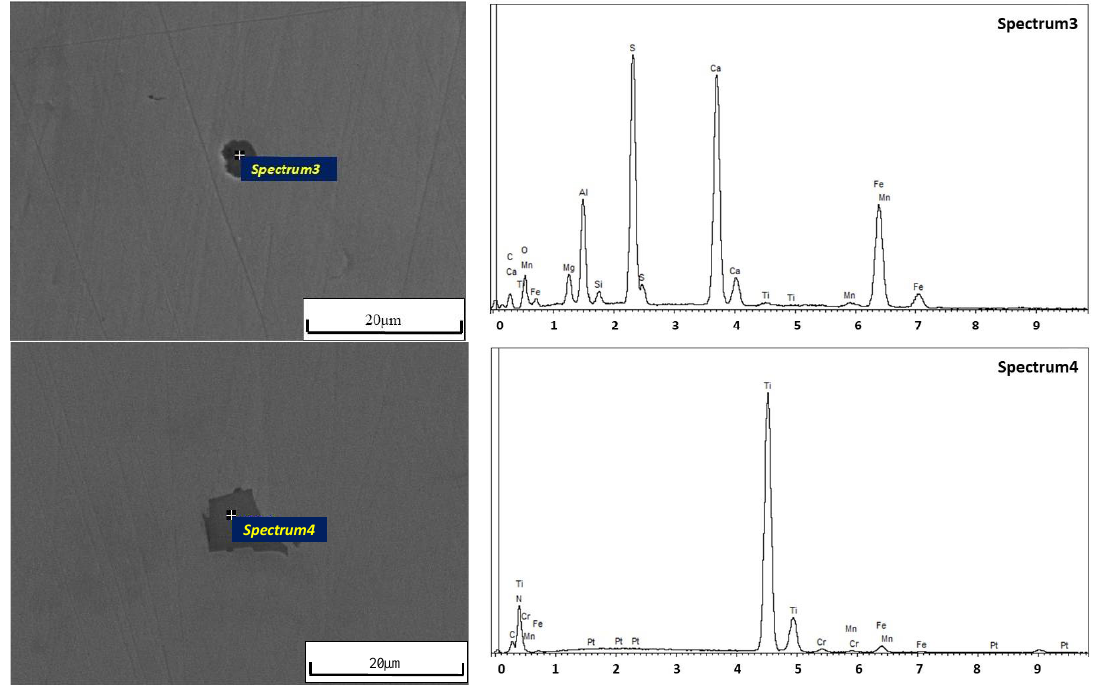
Figure 12. Morphology and distribution of microscopic inclusions in general porosity steel.